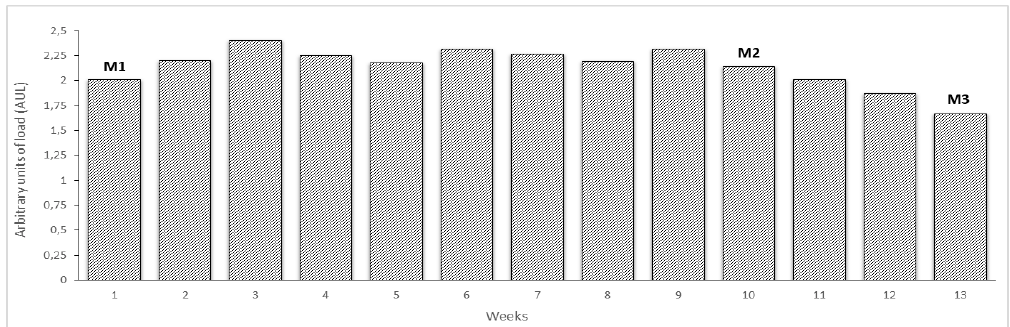
Figure 1. Training load (UAL) and evaluation moments during the 13 weeks macrocycle